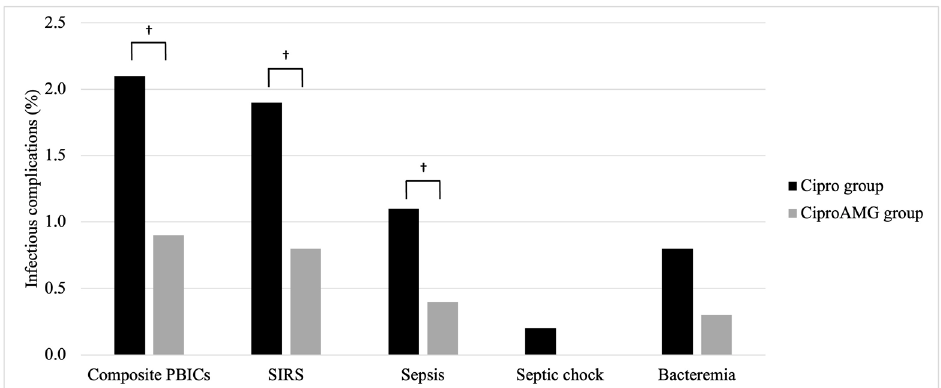
Figure 3. Individual and pooled post-prostate biopsy infectious complications rates from 2010 to 2018. The bar graph represents the rates per post-individual infectious complication and is stratified according to groups (Cipro group and CiproAMG group). ✝ p < 0.05.